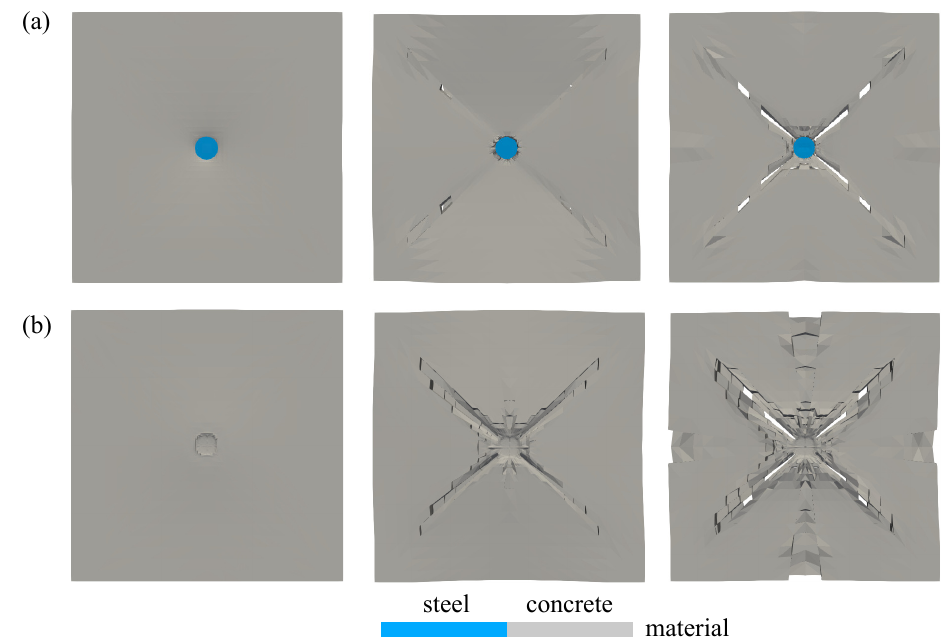
Figure 17. Crack growth visualisation of thick plate impact test: ( a ) top and ( b ) bottom view.